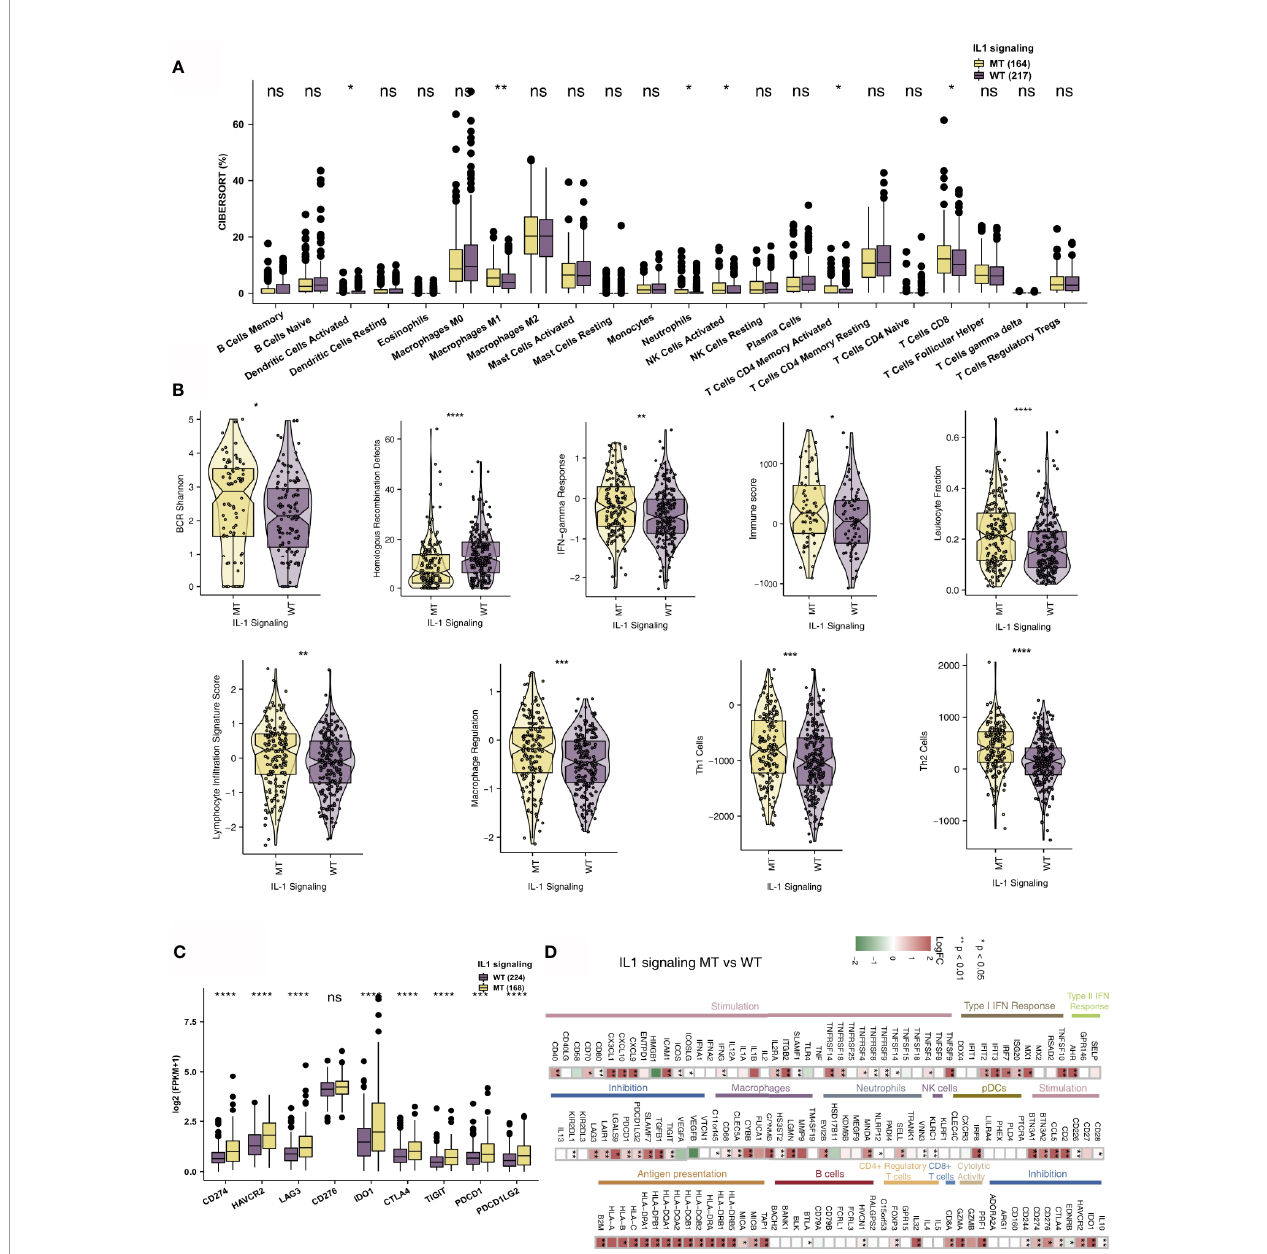
FIGURE 4 | IL-1-MT COAD is associated with an in fl ammatory TME. (A) Comparison of the fractions of 22 immune cells between IL-1-MT and IL-1-WT tumors in the TCGA-COAD cohort. (B) Comparison of the immune-related signatures between IL-1-MT and IL-1-WT tumors in the TCGA-COAD cohort. (C) Comparison of the expression levels of immune checkpoint molecules between IL-1-MT and IL-1-WT tumors in the TCGA-COAD cohort. (D) Heatmap depicting the mean differences in immune-related gene mRNA expression between IL-1-MT and IL-1-WT tumors across different cancer types. The x-axis of the heatmap indicates different cancer types, and the y-axis indicates gene names. Each square represents the fold change or difference of each indicated immune-related gene between IL-1-MT and IL-1-WT tumors in each cancer type. Red indicates upregulation, while blue indicates downregulation (*P < 0.05; **P < 0.01; ***P < 0.001; ****P < 0.0001; ns, not signi fi cant; Mann-Whitney U